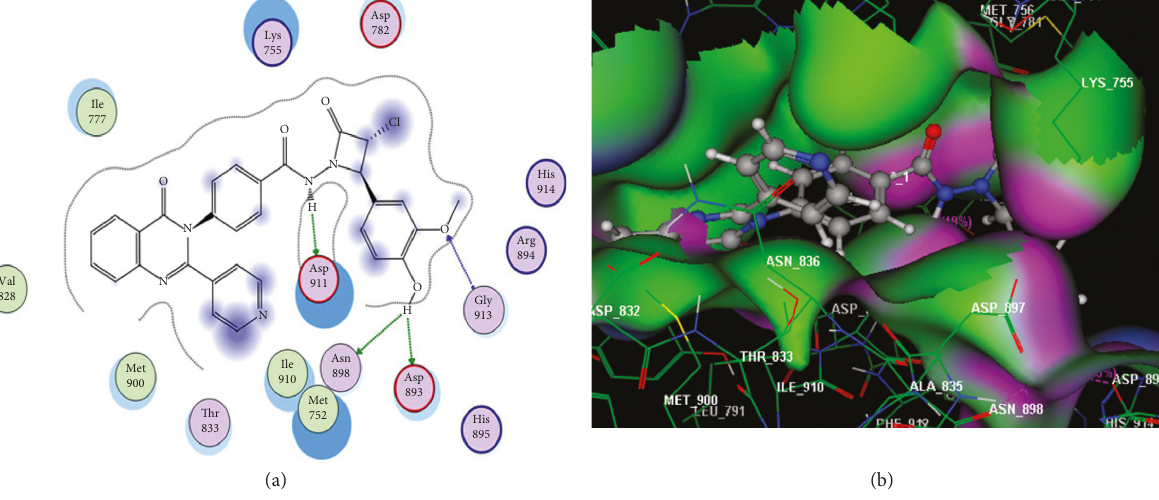
Figure 3: The suggested binding form of derivative 12 docked in the active position of PI3K showing (a) 2D and (b) 3D ligand-receptor interactions (H bonds are clarified as arrows; colored gray for C atoms, blue for N atoms, and red for O